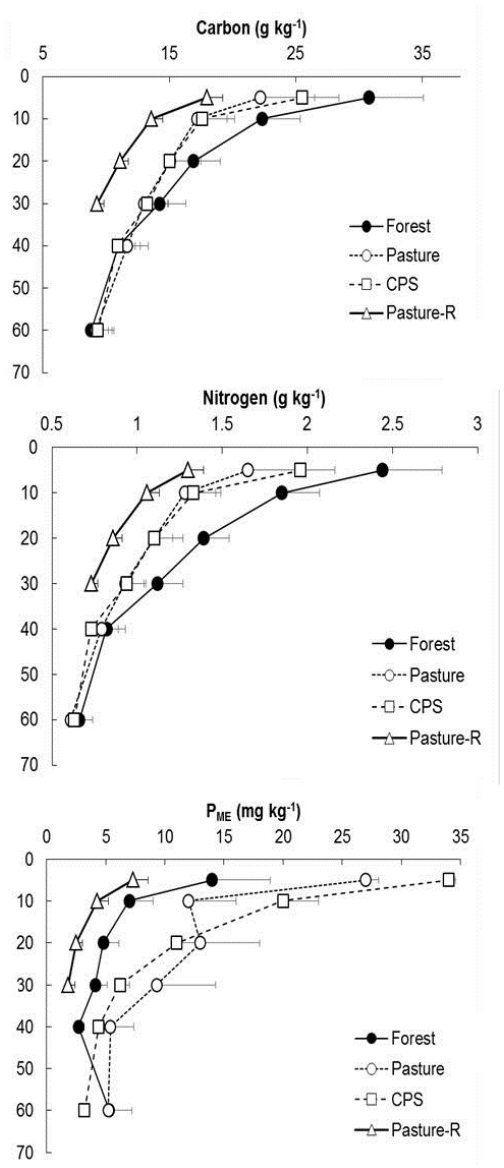
Figure 2. Soil depth variability of (a) carbon, (b) nitrogen and (c) Mehlic-3 extracted phosphorus (P ME ) in forest, pasture and CPS soils of the paired study sites and of the regional pasture survey (Pasture-R). Points represent the means by soil depth and the hori- zontal bars are standard